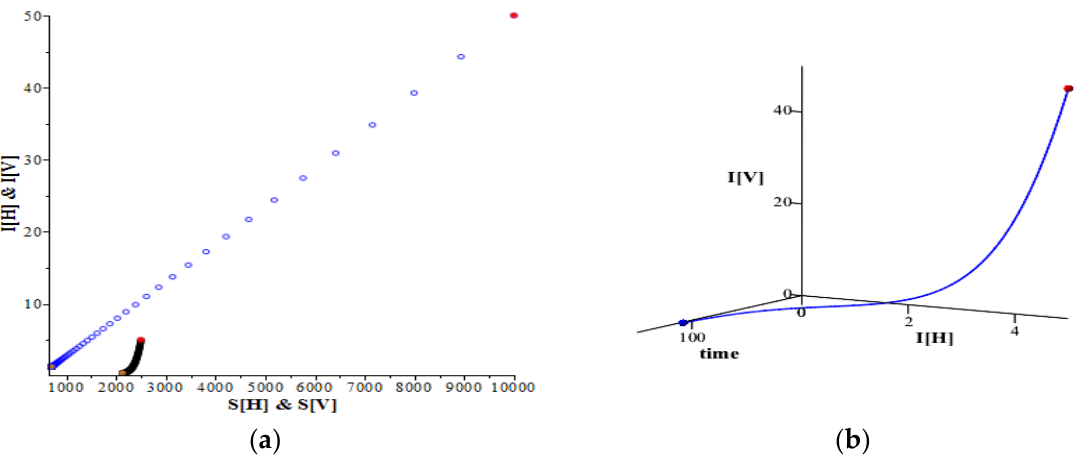
Figure 6. The phase port of S H ( t ) and I H ( t ) (black) and the phase port of S V ( t ) I V ( t ) (blue) are shown in ( a ). ( b ) shows the trajectory of I H ( t ) and I V ( t ) in a 3D graph. The red dots in both figures indicate the initial values of the system. The parameters are the same as in Figure 5.